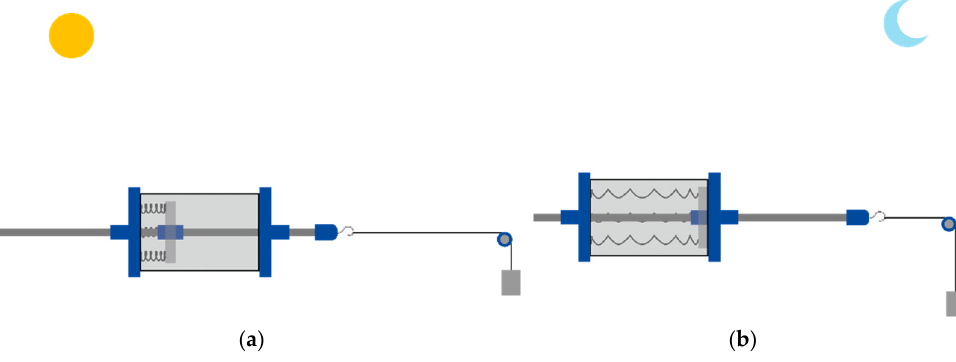
Figure 2. SMA-based actuator phases; ( a ) activated and ( b ) deactivated arrangements.